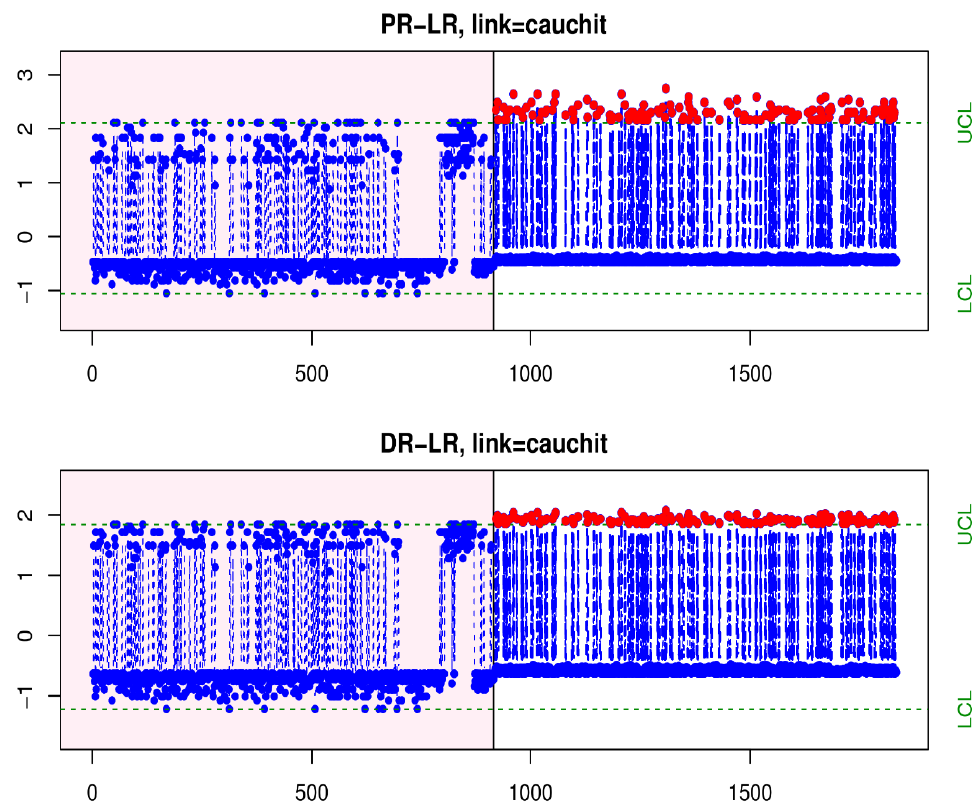
Figure 4. Control chart based on PR and DR with the c-log-log link function.